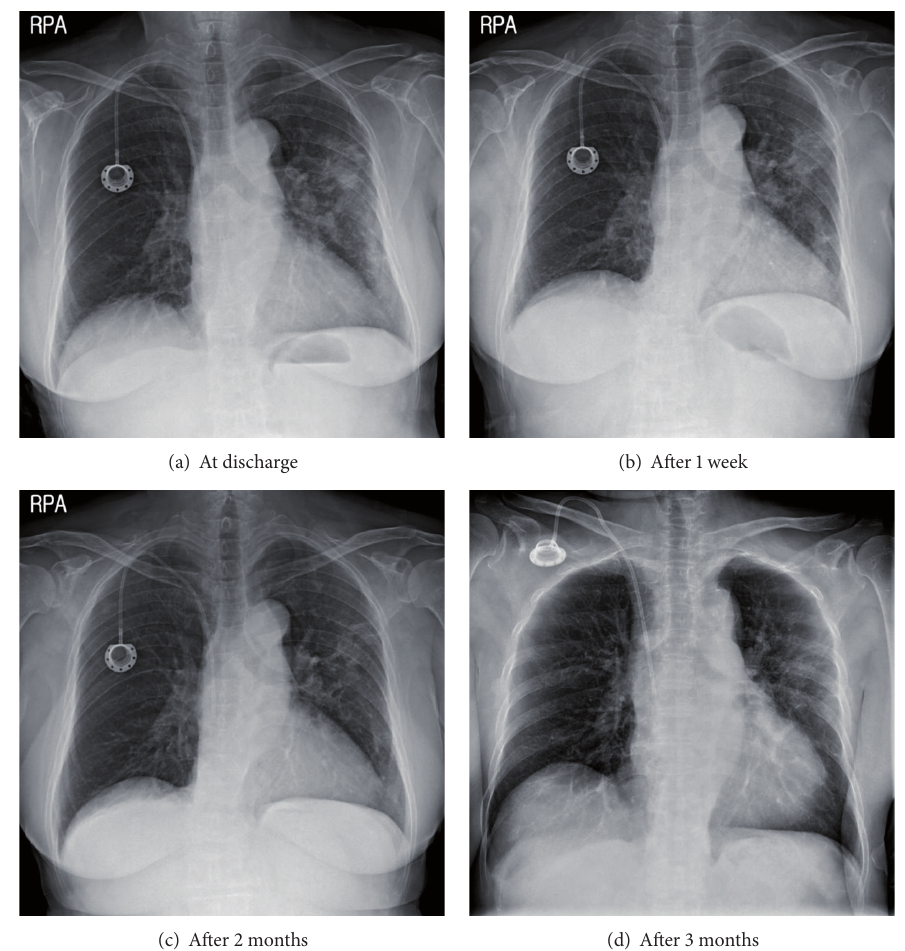
Figure 4: Resolution of chest X-ray after treatment for